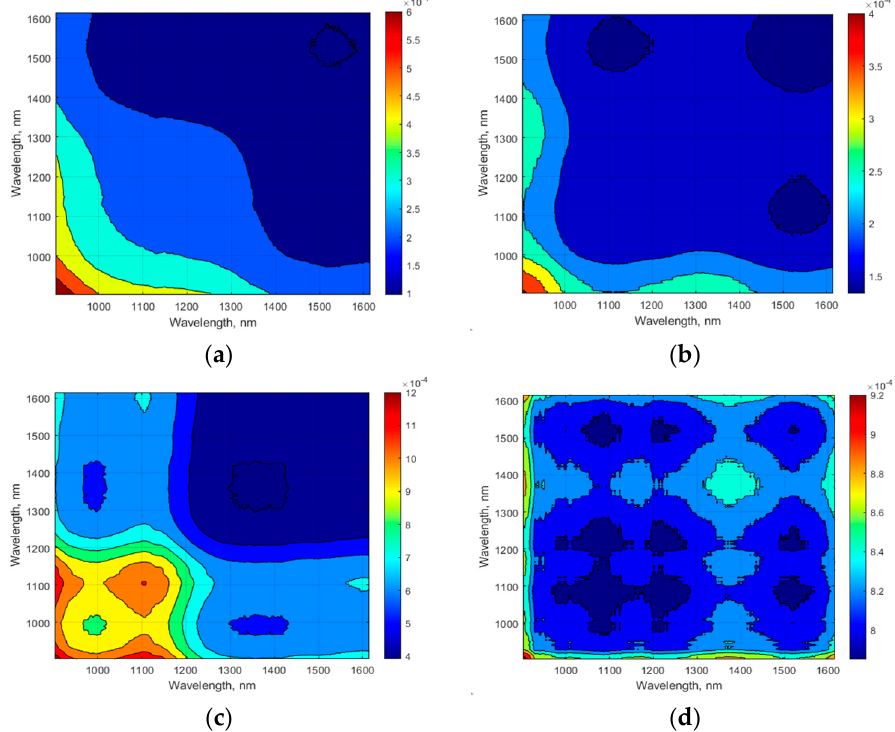
Figure 5. 2D-COS synchronous spectra of the samples S2 ( c , d ) and S6 ( a , b ). ( a , c ) Foil side excitation; ( b , d ) electrode side excitation.